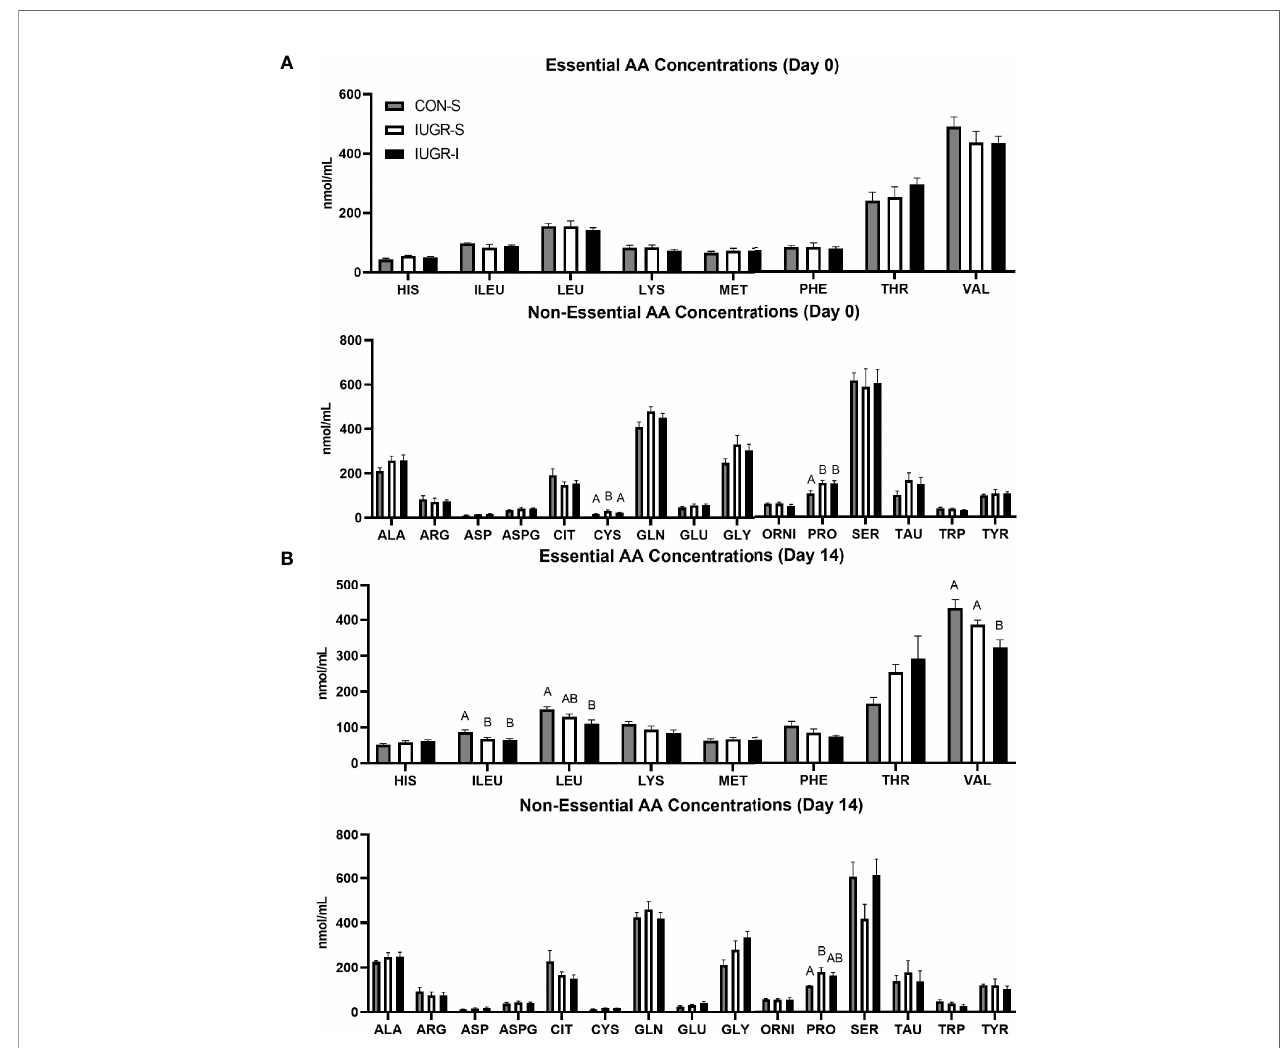
FIGURE 4 | Fetal arterial plasma amino acids (AA) concentrations before infusion and on the fi nal day of infusion. Fetal essential and non-essential AA concentrations on (A) day 0 and (B) day 14 of the infusion period. Day 1: CON-S (grey bar, n=6), IUGR-S (white bar, n=7), and IUGR-I (black bar, n=11). Day 14: CON-S (grey bar, n=4), IUGR-S (white bar, n=5), and IUGR-I (black bar, n=5). Values are mean ± SEM. Statistical signi fi cance was designated at P ≤ 0.05 by one- way ANOVA, and Fisher ’ s least signi fi cant difference post hoc test to determine differences among groups (different letters are statistically signi fi cantly different from each other, P ≤